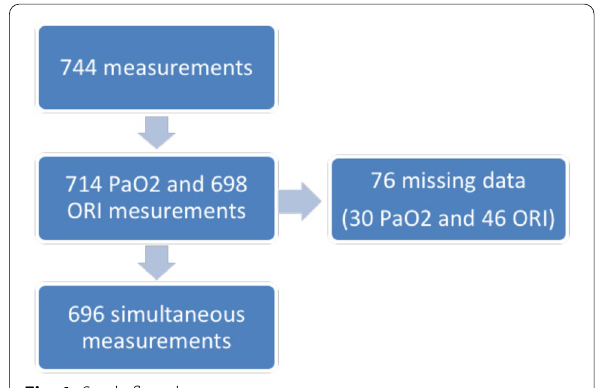
Table 1. Patients had a high SAPS 2 score (mean: 43), were frequently hospitalized after subarachnoid hemor-